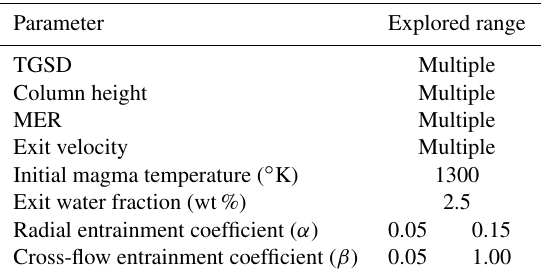
Table 2. Input parameters used within the FPlume and FALL3D models. Multiple TGSDs are tested as input for the simulations (see Sect. 3.1). The column height, MER, and exit velocity are set as multiple values (see Sect. 3.2). The simulation scheme is presented in Sect. 3.2 and Fig. 7.